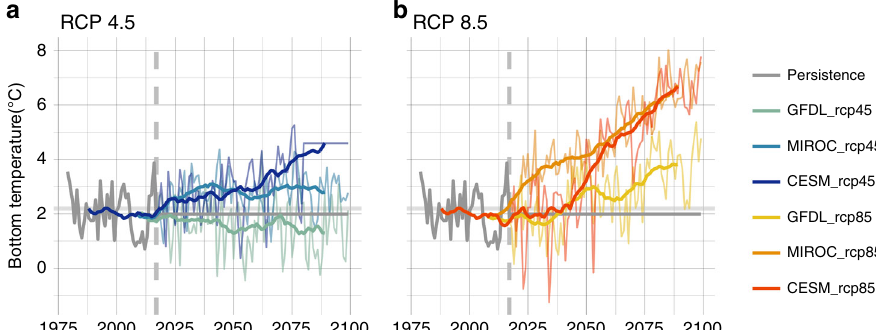
Fig. 2 Future Bering Sea bottom temperatures relative to the ~2.1 OC tipping point. Bias-corrected projections of survey replicated annual mean summer bottom temperature (°C) for the Bering Sea under CMIP5 Representative Concentration Pathway (RCP) 4.5 ( a ) and RCP 8.5 ( b ). Annual temperatures (thin lines) and 20 year running mean (thick lines) temperatures are based on survey replicated samples from the downscaled ROMSNPZ Bering10K model. Persistence is based on 2006 – 2017 average conditions from the downscaled ROMSNPZ hindcast (gray line). Vertical dashed lines represent the start of the projection period (2018). Projections include three global climate models; the Geo fl uid Dynamics Lab Earth System Model (GFDL-ESM2M), the MIROC-ESM, and the National Center for Atmospheric Research Community Earth System Model (CESM1). See ref. 29 for more